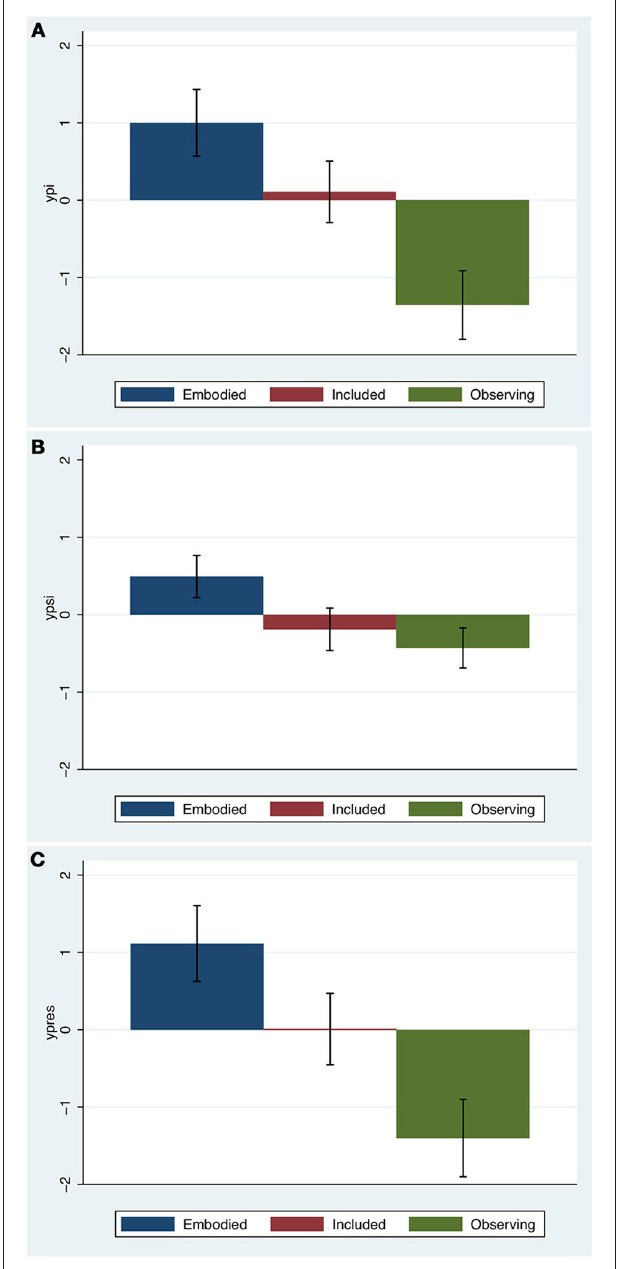
FIGURE 4 | Bar charts for the presence composite variables by condition. The heights show the means and the whiskers the standard errors. (A) Place Illusion, (B) Plausibility Illusion, (C) Overall